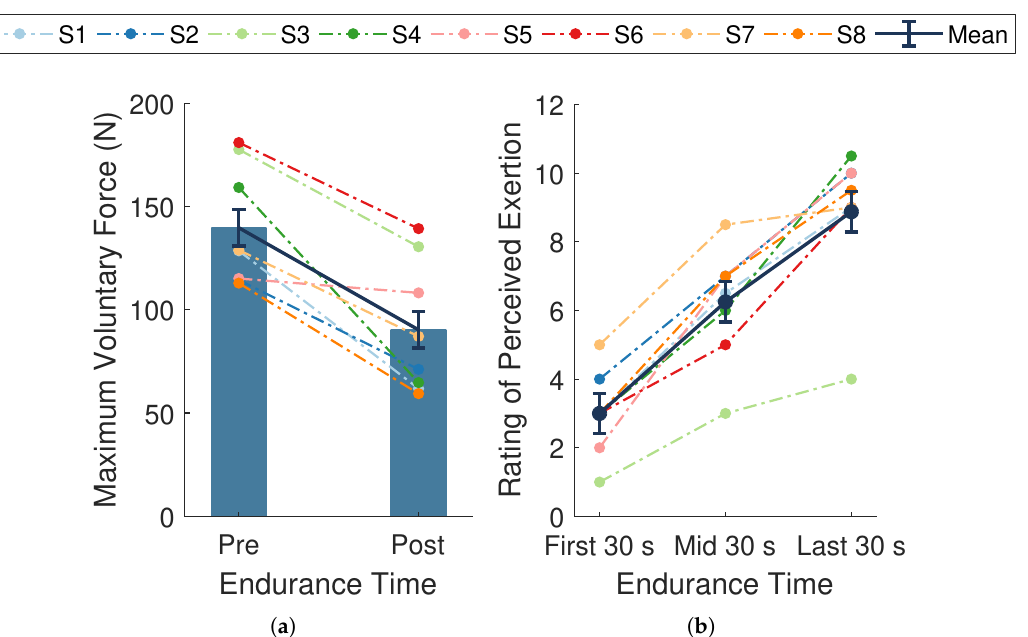
Figure 4. Measures of fatigue. ( a ) Maximal voluntary contraction (MVC) forces taken at baseline (pre-endurance task) and follow-up (post-endurance task). ( b ) Ratings of perceived exertion (RPE) during the first, middle, and last 30 s of the endurance task. Dark blue bars and data points connected by solid lines are means ± SE. Dotted lines represent data from a single participant ( n = 8) whose assigned color is consistent across figures. MVC force significantly declined ( p < 0.001, d = − 1.99) and RPE significantly increased over time ( p < 0.001, η 2 p =